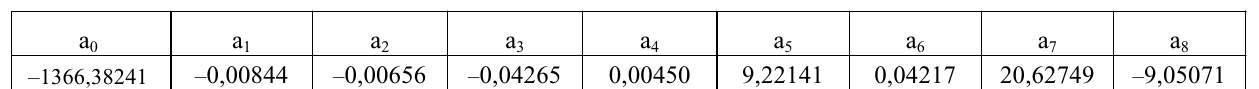
Table 6 . Coefficients of multiple linear regression